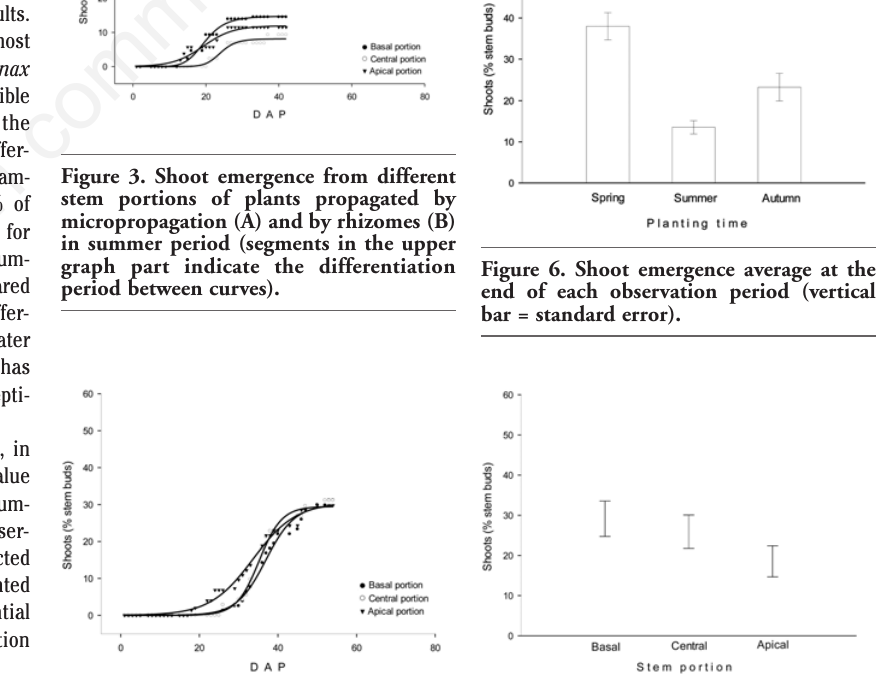
Figure 5. Shoot emergence from different stem portions of new stems in autumn period (segments in the upper graph part indicate the differentiation period between curves).